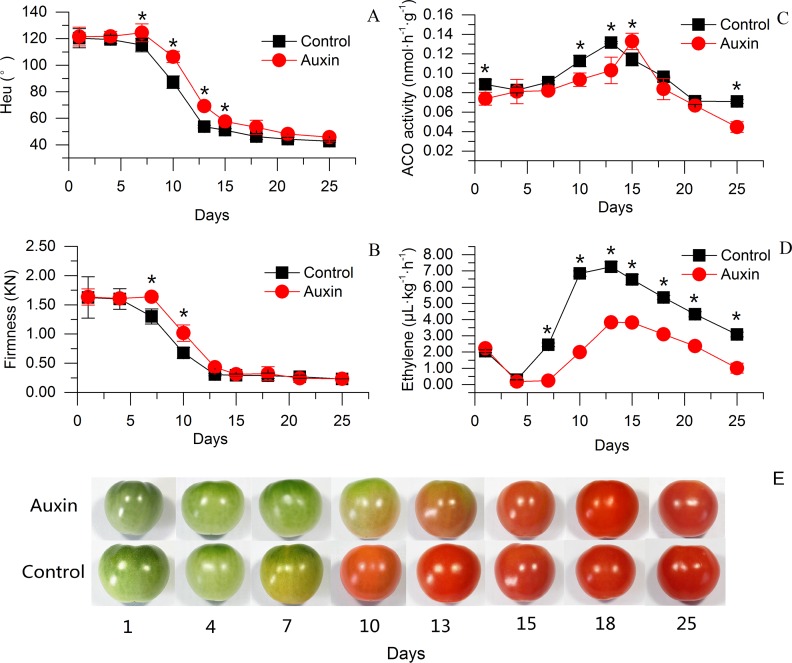
Physiological changes induced by exogenous auxin application in tomato fruit.The changes in (A) hue angle, (B) firmness, (C) ACO activity, (D) and ethylene and the pictures of tomato fruits after auxin treatment. Error bars indicate the standard error of three replicates. Asterisks (*) represent significant differences between the control and auxin treatments (Student's t-test, P < 0.05).